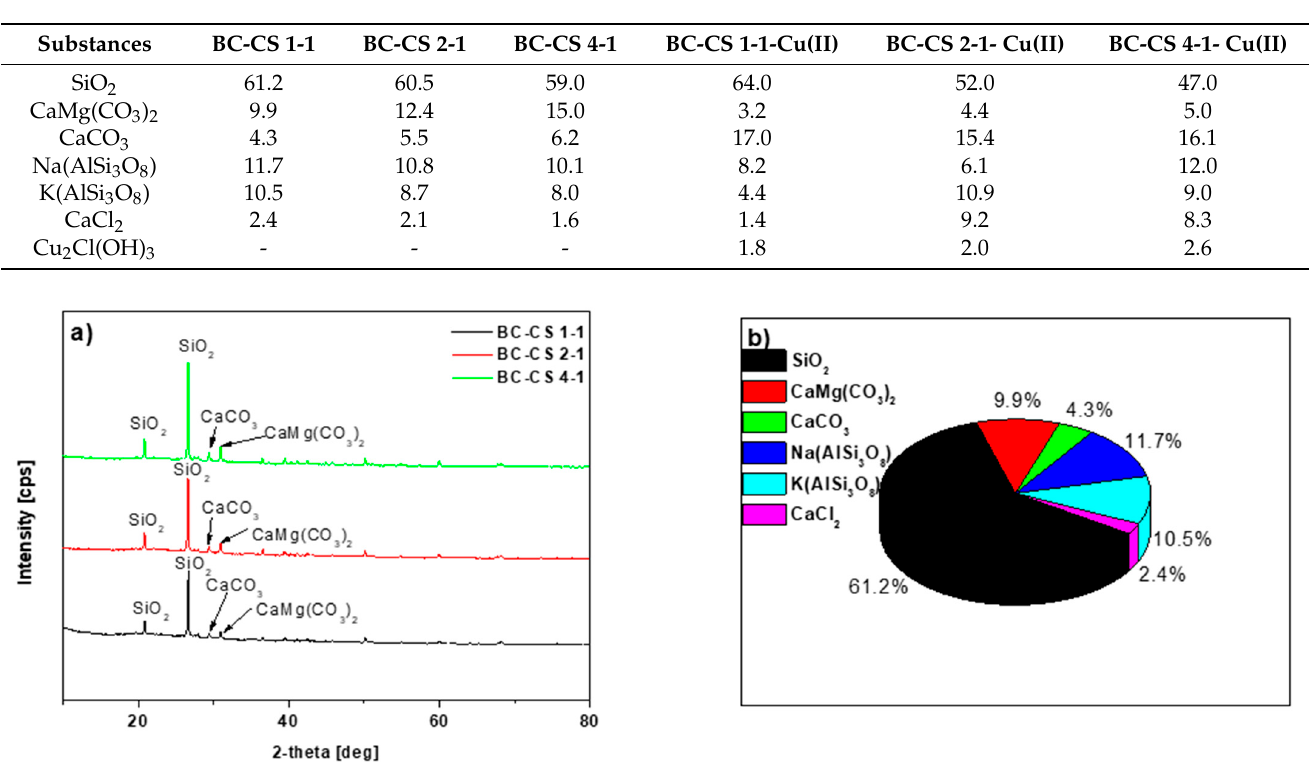
Figure 4. Pore size distribution of ( a ) BC-CS 1-1, ( b ) BC-CS 2-1 and ( c ) BC-CS 4-1. Table 2. Semi-quantitative analysis of BC-CS 1-1, BC-CS 2-1 and BC-CS 4-1 based on the XRD methods before and after the Cu(II) ion sorption.